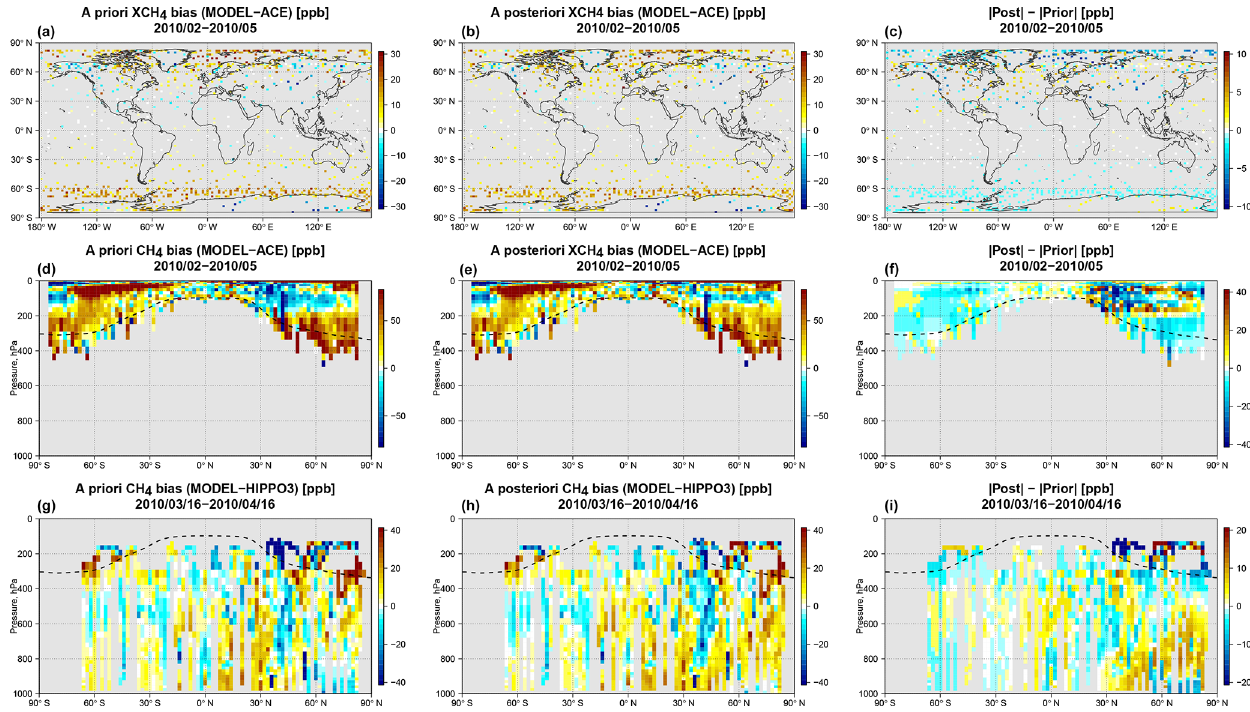
Figure 11. Same as Fig. 10 but for the 2 ◦ × 2.5 ◦ resolution model.